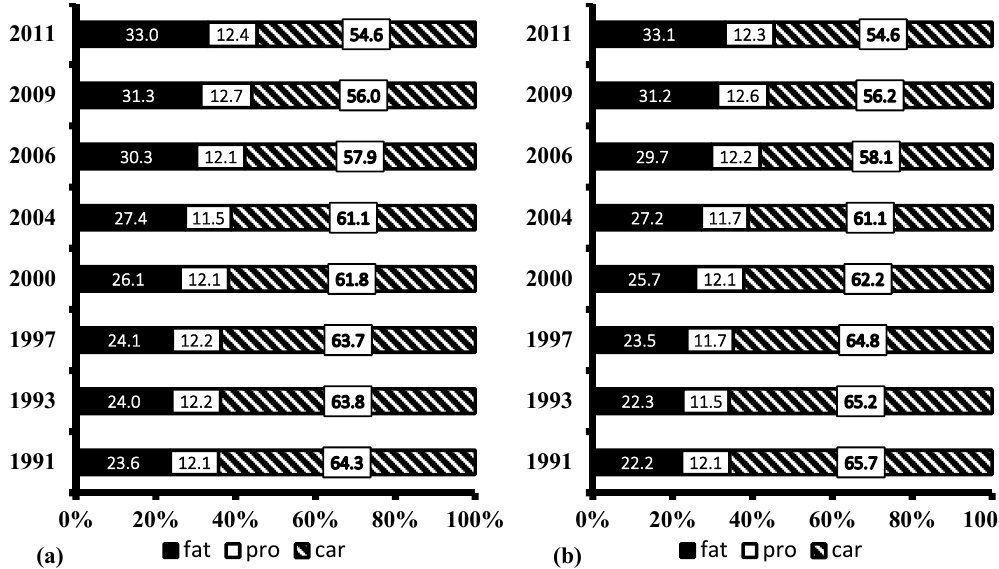
Figure 1. Percentages of energy from protein, carbohydrate and fat in Chinese rural adults from 1991 to 2011 by gender: ( a ) male; ( b ) female. Proportions were adjusted for age, sex, region, income, urbanicity. There was as significant trend in the proportions of energy from fat and carbohydrate across the survey years ( p < 0.0001; test for trend).